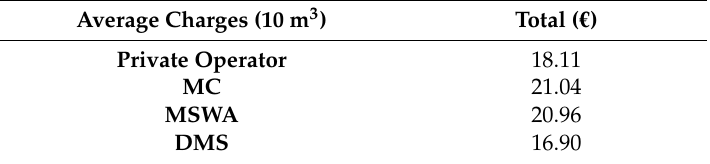
Table 6. Average monthly WSS charges removing the rent and investment subsidy e ff